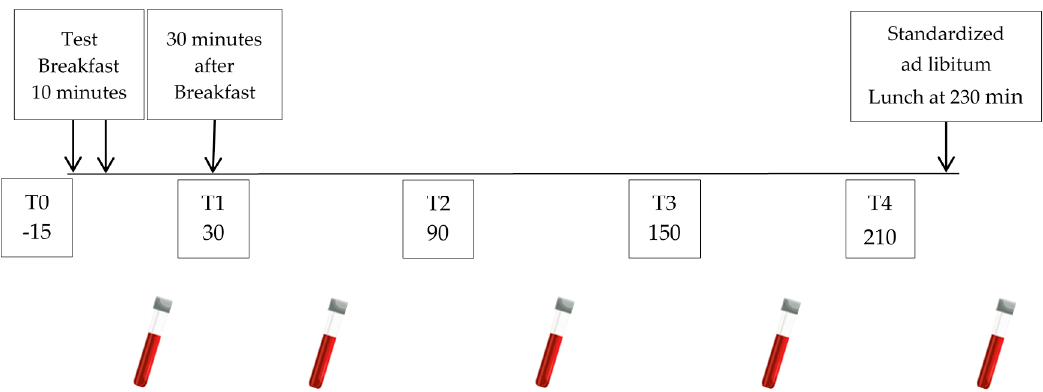
Figure 1. Study design for blood collection and food intake.